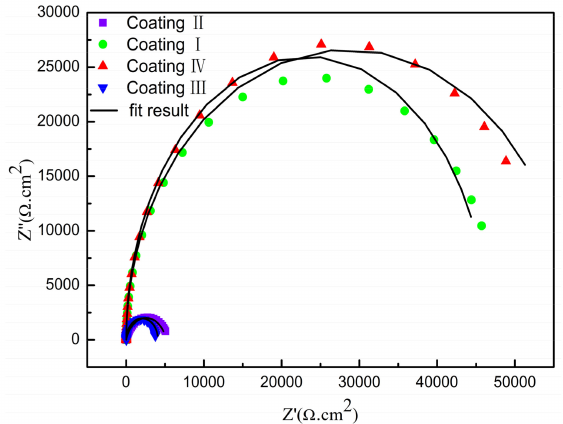
Figure 16. Nyquist of substrate and coatings with different powers.